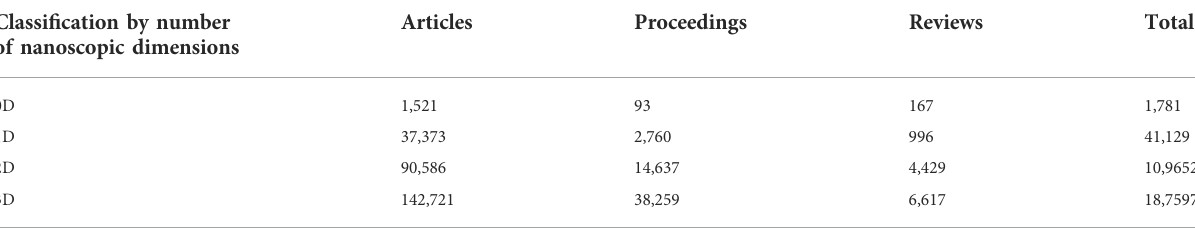
TABLE 1 Total number of publications in WoS during 2002 – 2022 in the subject n D structure materials ( n = 0, 1, 2, and